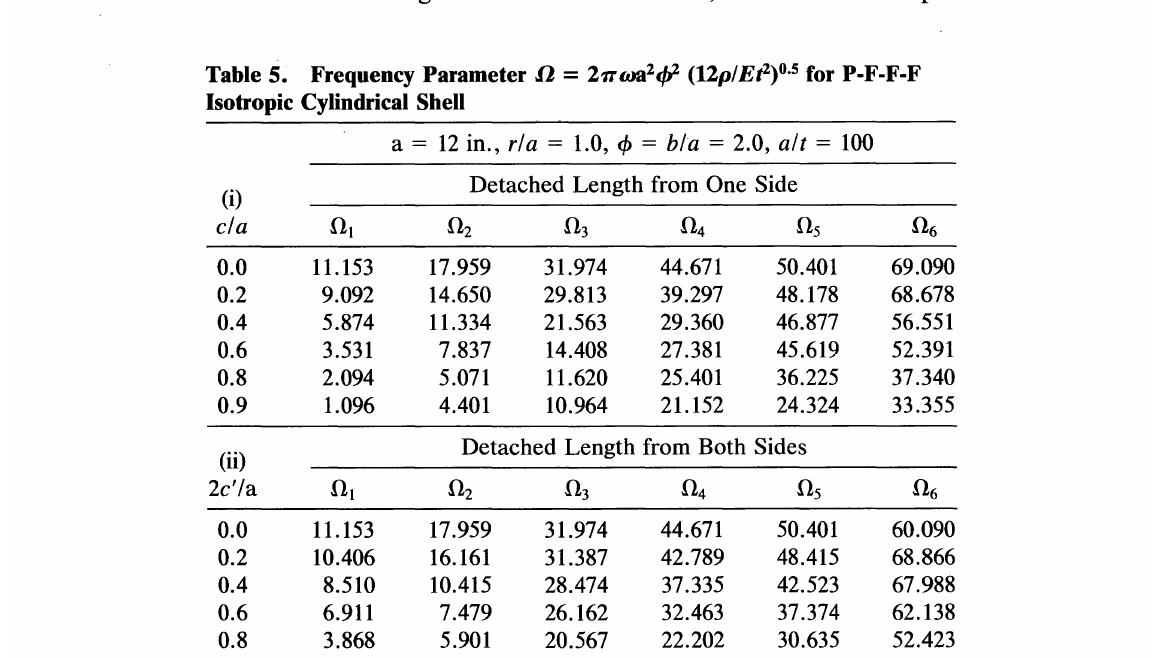
Table 5. Frequency Parameter Isotropic Cylindrical